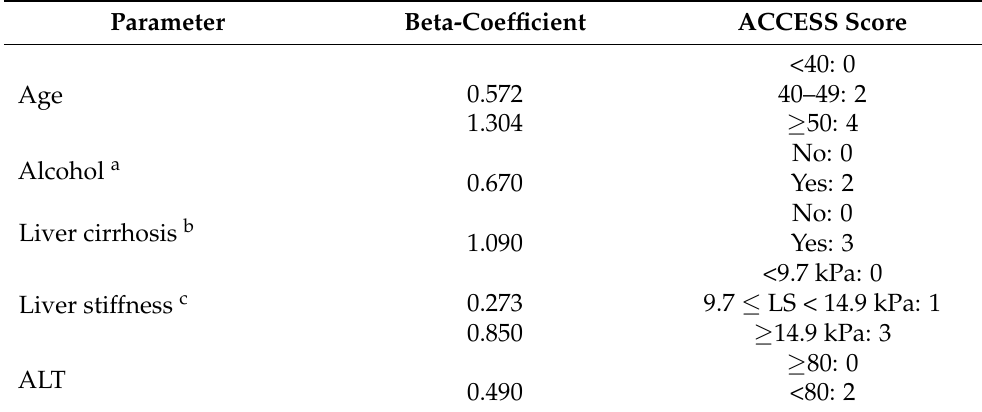
Table 3. Derivation of the ACCESS prediction score for hepatocellular carcinoma using the derivation cohort ( n = 1239).